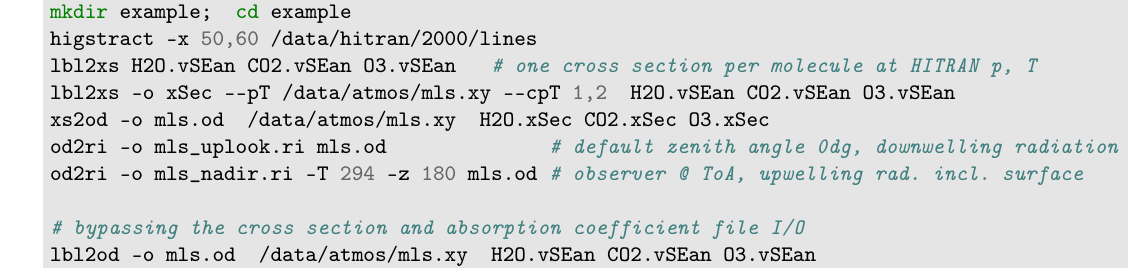
line Figure 2. Typical workflow for lbl modeling with Py4CAtS in a Unix-like shell: Hitran/Geisa → parameter extracts cross sections absorption coefficients optical depth radiance / intensity. Output is not shown. All functions support the -h option to ask for help, in particular a list of all available options/flags. For some notes on option parsing see Appendix A.7.